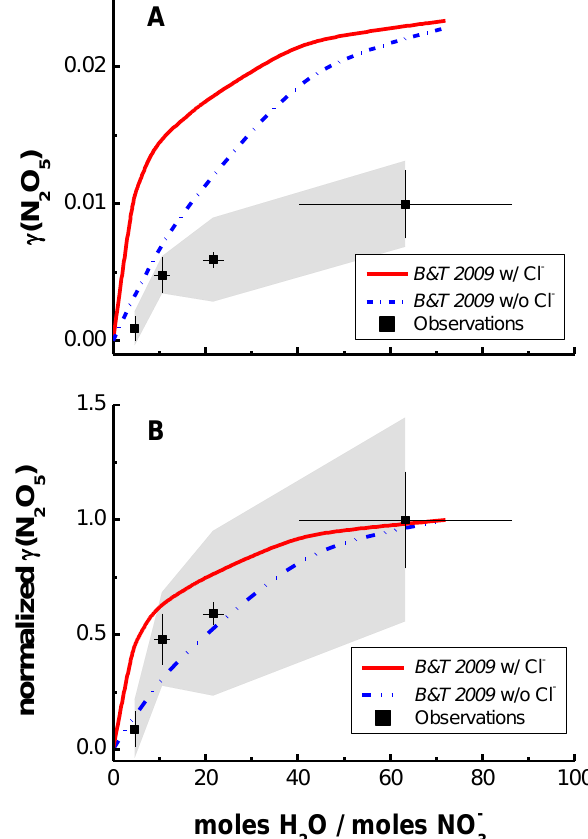
Fig. 5. (A) The observed dependence of N 2 O 5 reaction probabil- ities (black squares) on the water to nitrate mole ratio (i.e. “the nitrate effect”). Parameterized reaction probabilities are also in- cluded for comparison. (B) Observed (black squares) and param- eterized reaction probabilities normalized to maximum values. For both panels, the shaded area represents estimated error from the precision of the measurement technique. The bars represent the 1 σ variation of 24-h averaged points in each